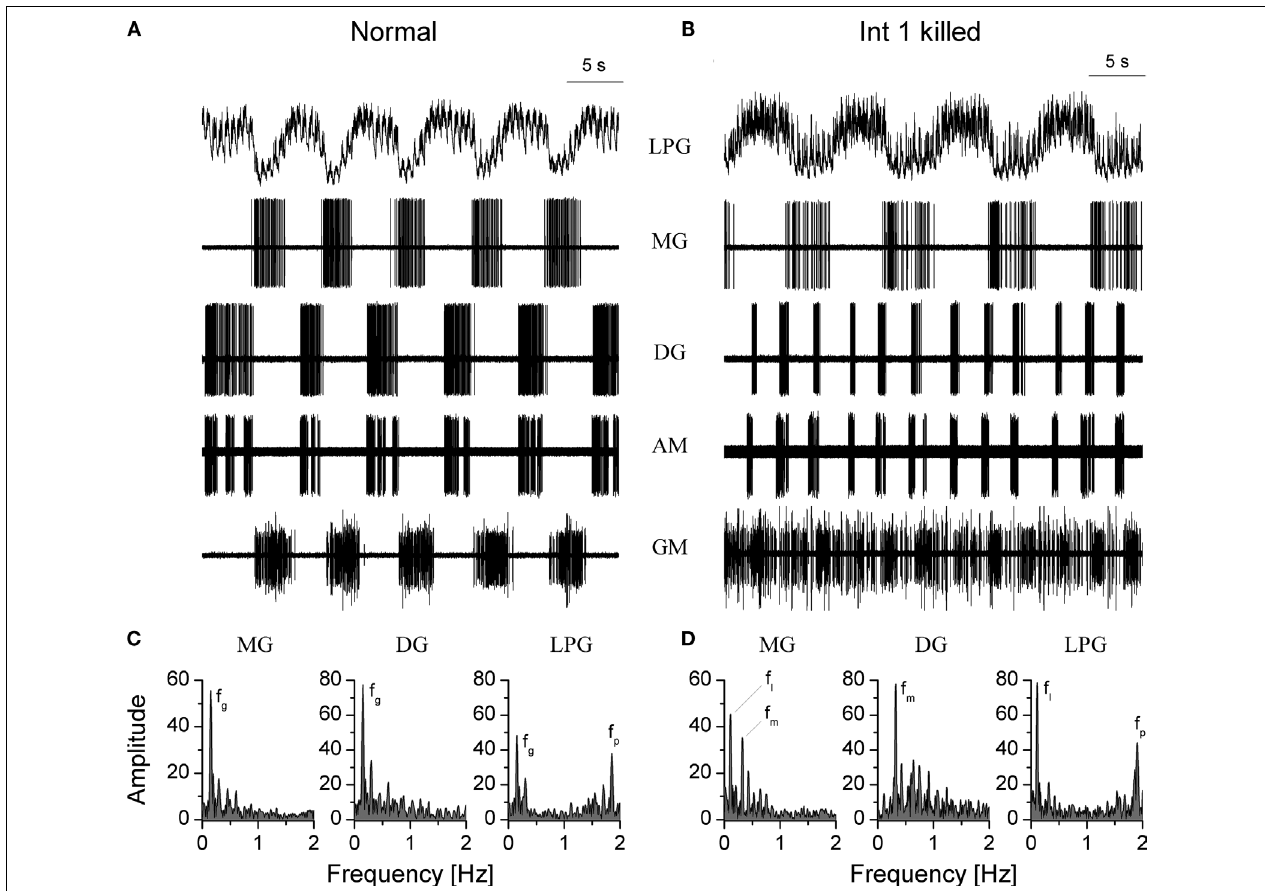
FIGURE 9 | Photoinactivation of the Int 1 neuron abolishes the synchronization between the medial and lateral tooth subcircuits. Control recordings in (A) show the normal rhythm in a combined preparation. One hour after the Int 1 neuron has been photoinactivated a fairly regular rhythm is observed in both the medial and lateral teeth neurons (B) . However, the two subcircuits are running at different burst frequencies, the medial neurons being nearly three times